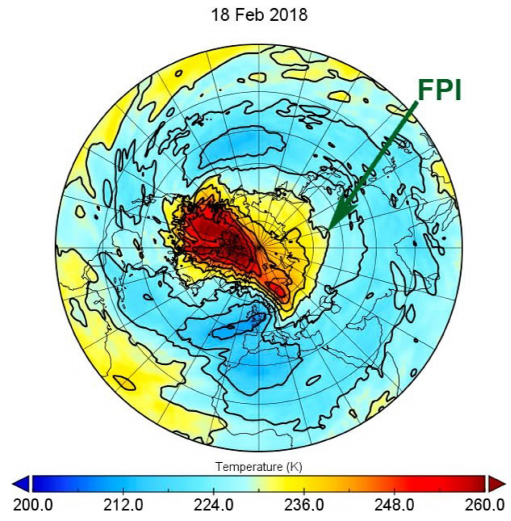
Figure 7. Same as Fig.